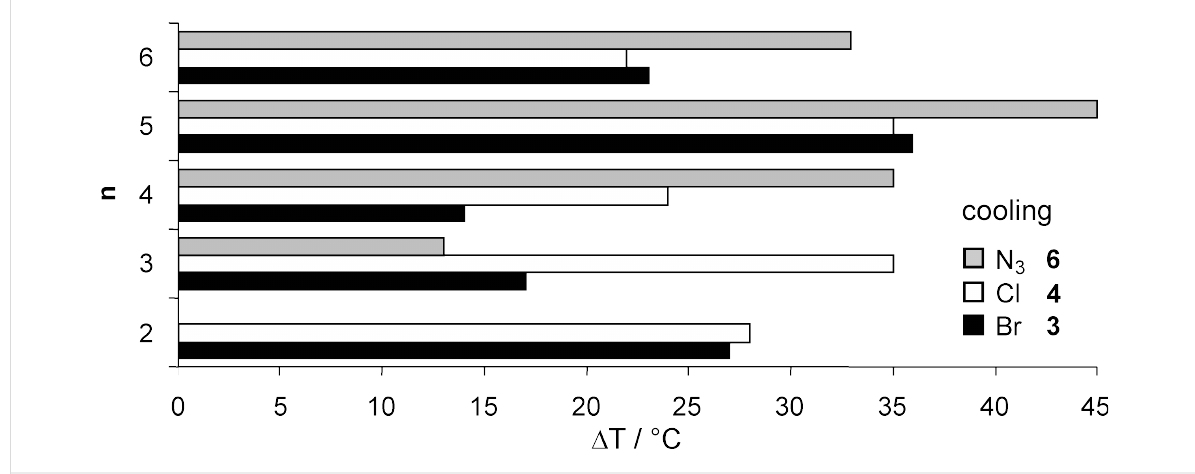
Figure 8: Comparison of the mesophase range Δ T for the different spacer lengths of compounds 3 , 4 and 6 : mesophase range upon cooling (cooling rate 10 K/min).